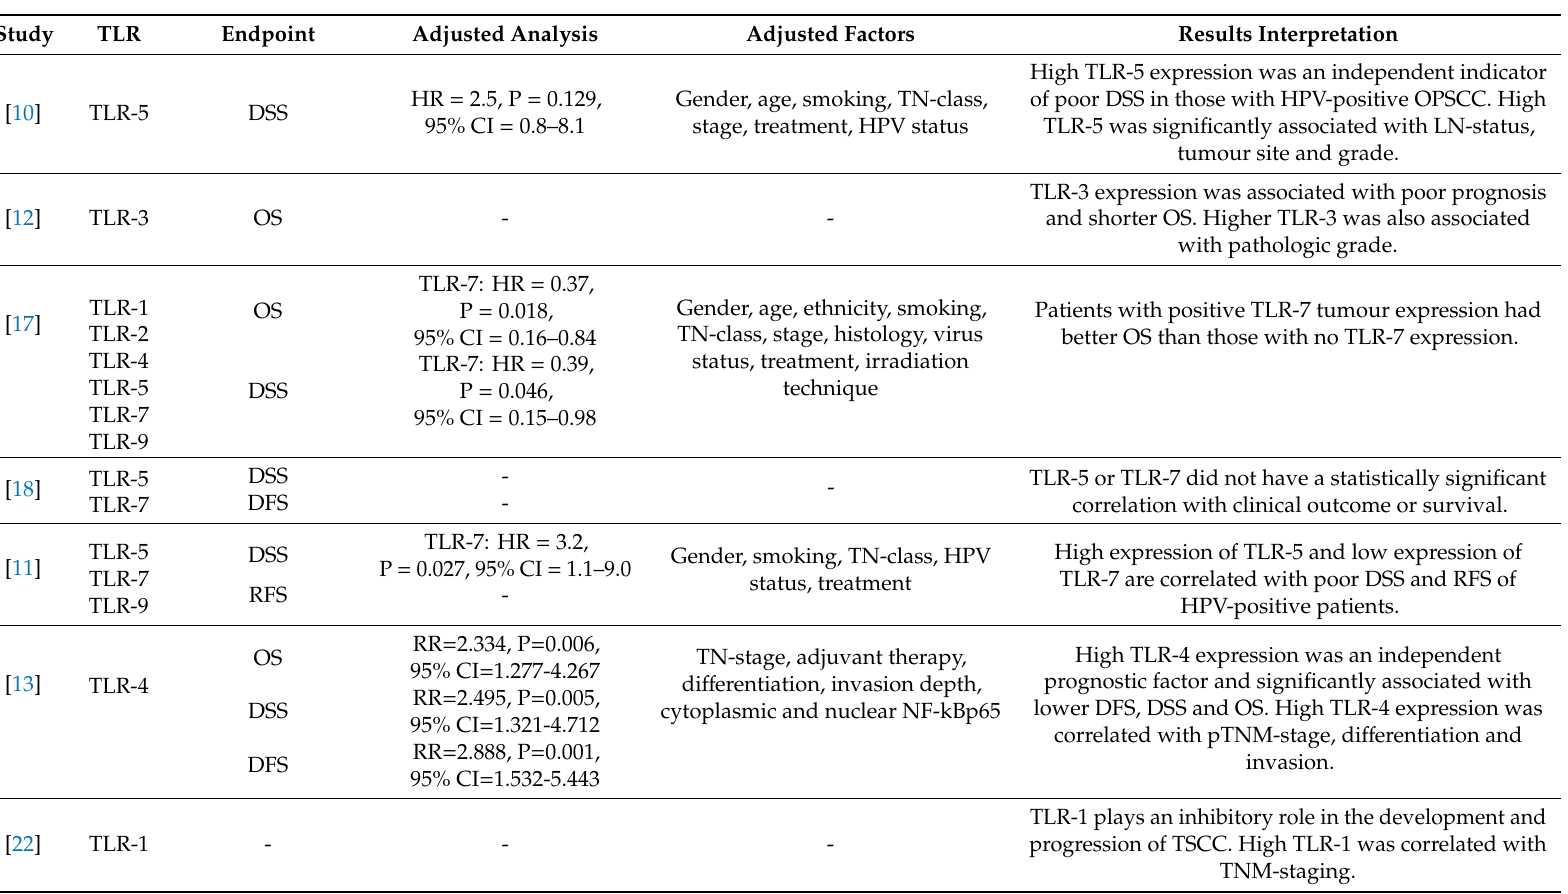
Table 3. Summary of the prognostic